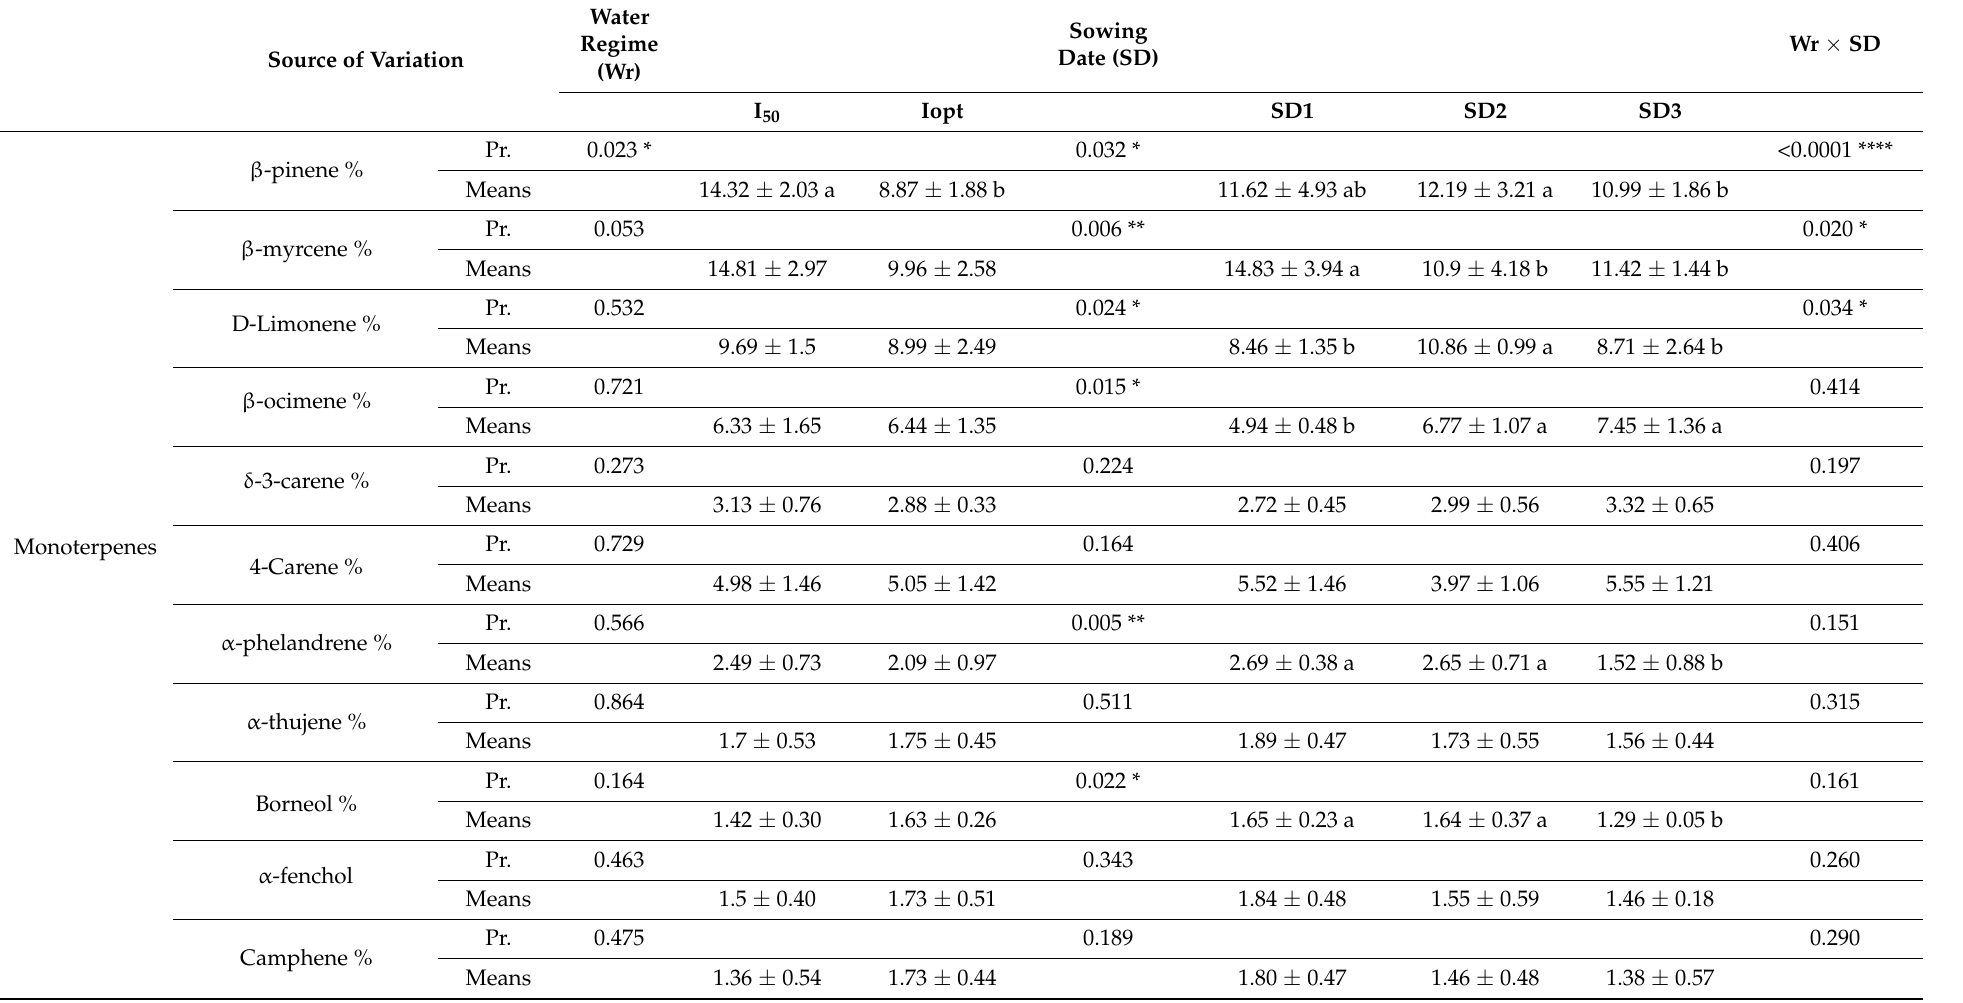
Table 2. The main essential oils extracted from the cannabis inflorescence as affected by the water regime and sowing date.